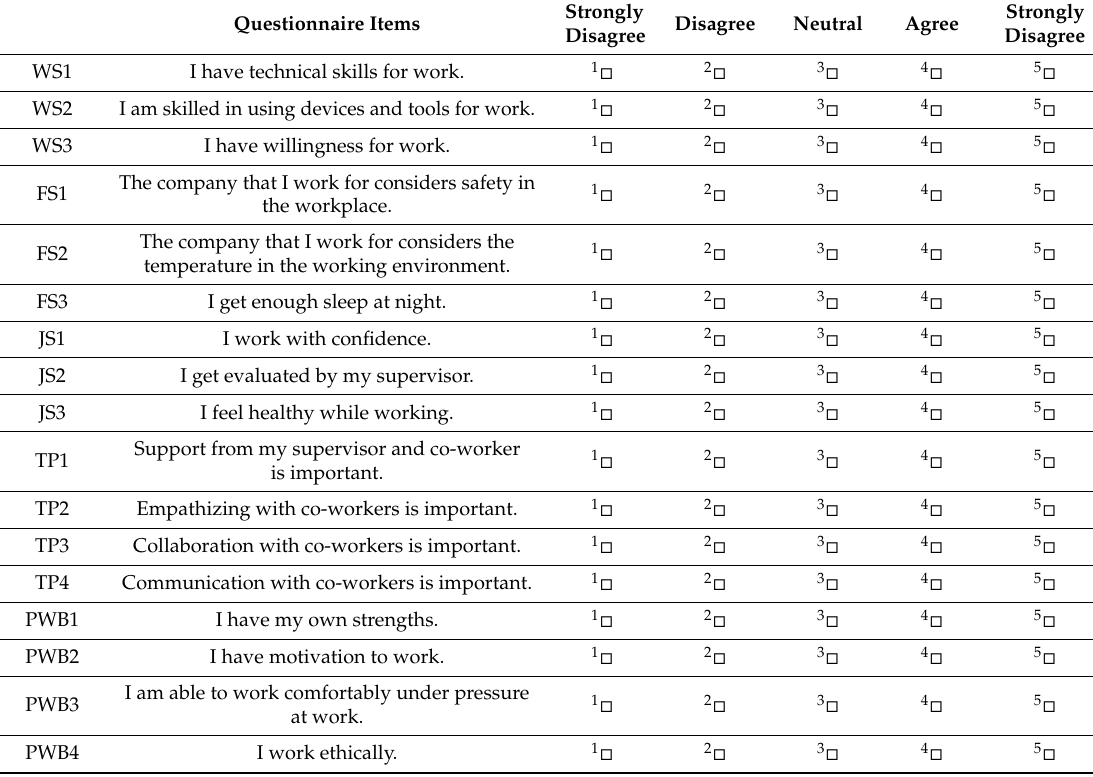
Table A1. Survey instrument on psychological factors and workers’